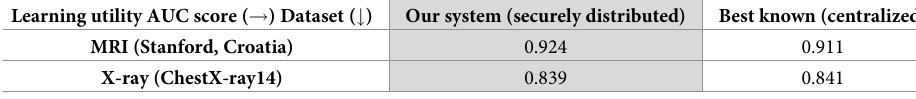
Table 1. Comparison of area-under-the-curve (AUC)